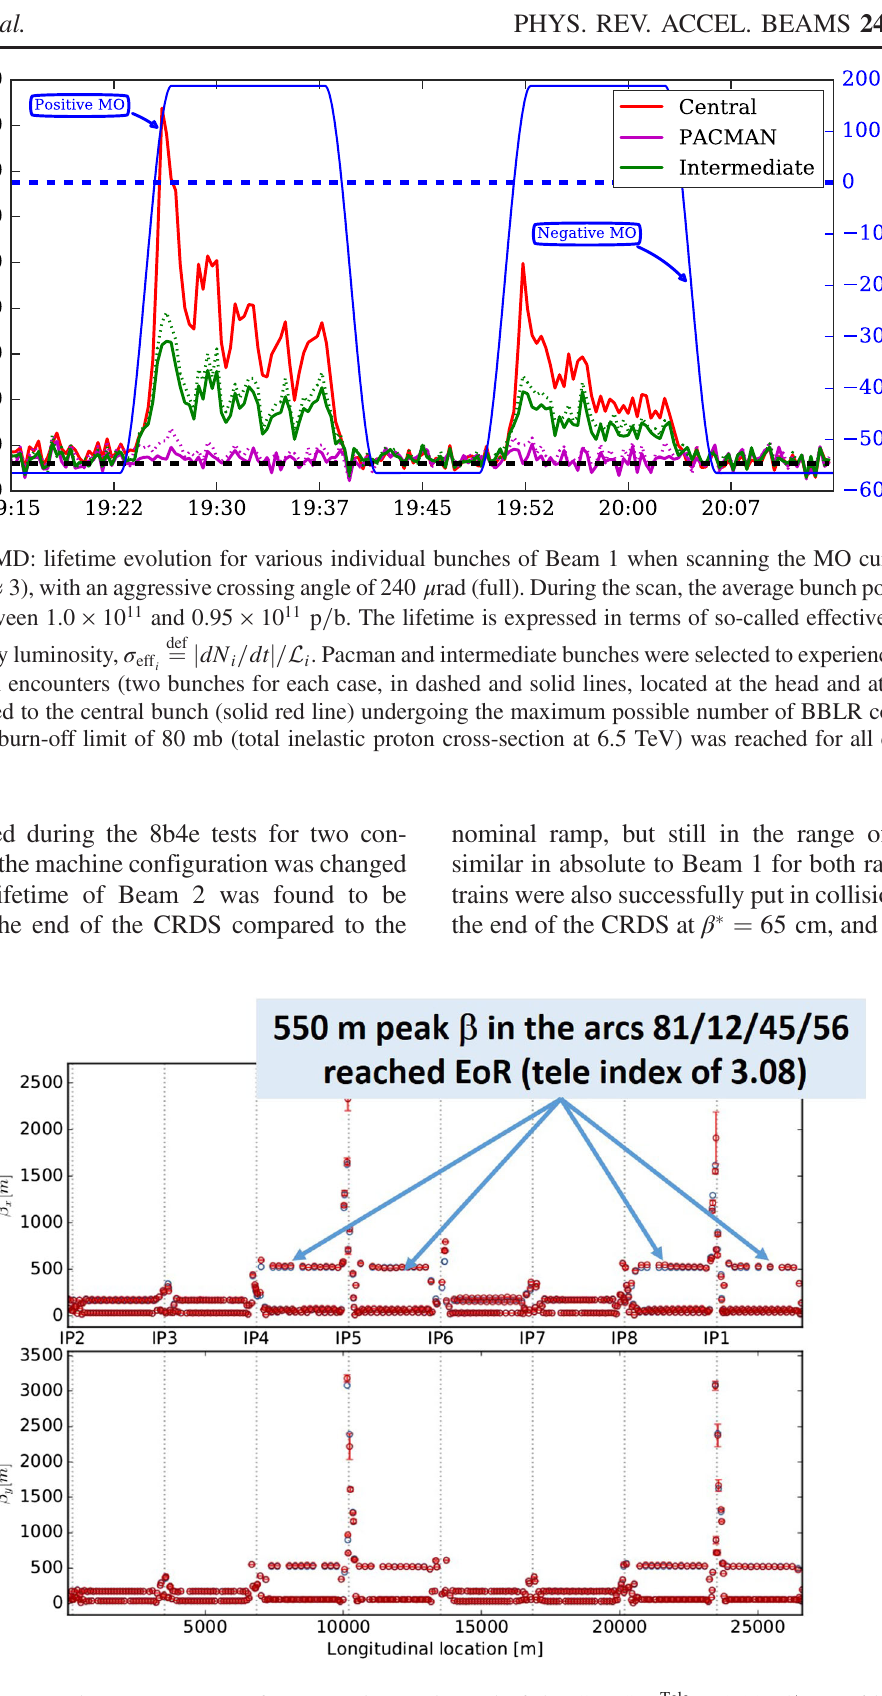
FIG. 7. 2018 ATS MD: optics measurement after correction at the end of the CRDS: r Tele ¼ 3 . 08 ( β (cid:1) effective tune spread almost tripled at constant MO